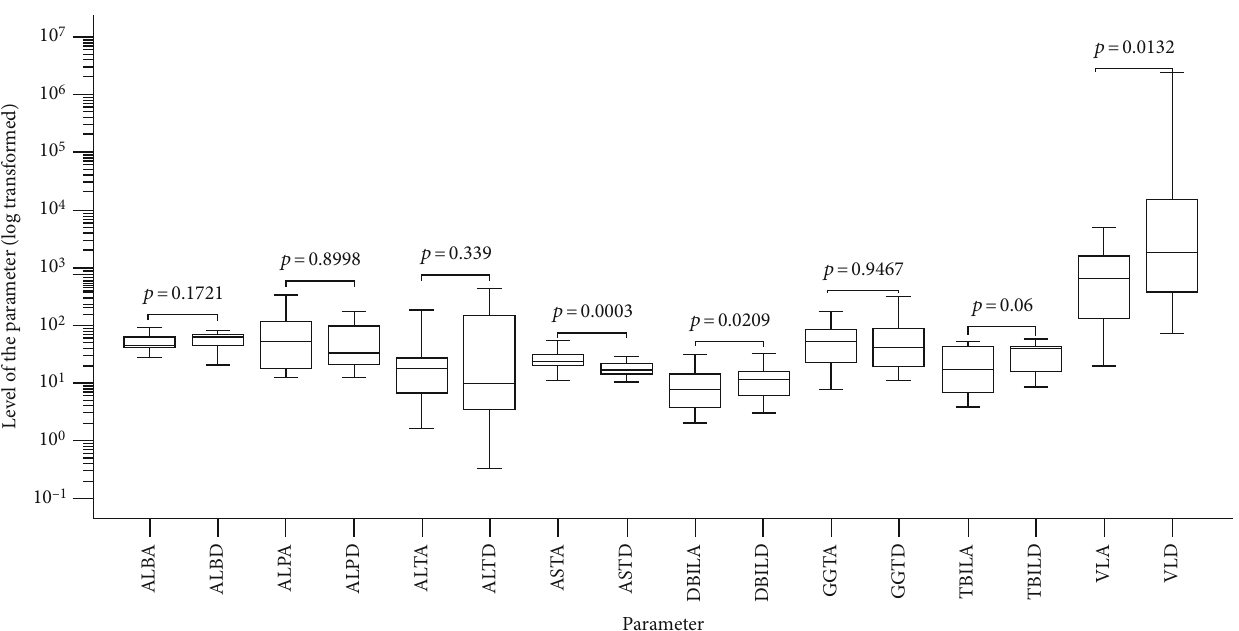
Figure 5: Box and Whisker plot showing the variation s in the levels of the clinical parameter investigated with the genotypes A and D: ALBA: albumin for genotype A; ALBD: albumin for genotype D; ALPA: alkaline phosphatase for genotype A; ALTA: alanine aminotransferase for genotype A; ALTD: alanine aminotransferase for genotype D; ASTA: aspartate aminotransferase for genotype A; ALTD: aspartate aminotransferase for genotype D; DBIL: direct bilirubin for genotype A; DBILD: direct bilirubin for genotype D; GGTA: gamma glutamyl transferase for genotype A; GGTD gamma glutamyl transferase for genotype D; TBILA: total bilirubin for genotype A; TBILD: total bilirubin for genotype D; VLA: viral load for genotype A; VLD: viral load for genotype